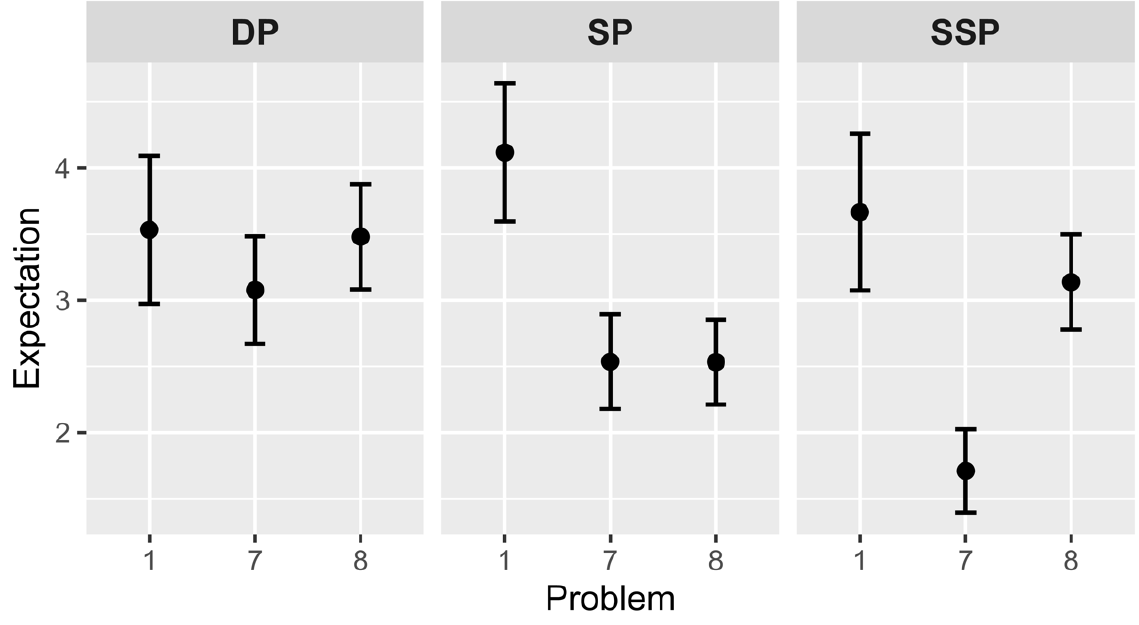
Figure 1. Subjective rating of expectations in different groups (1—expected solution, 7—unexpected). Note. Vertical bars denote standard errors. DP—different principle group, SP—same principle group, SSP—same structure and principle group.